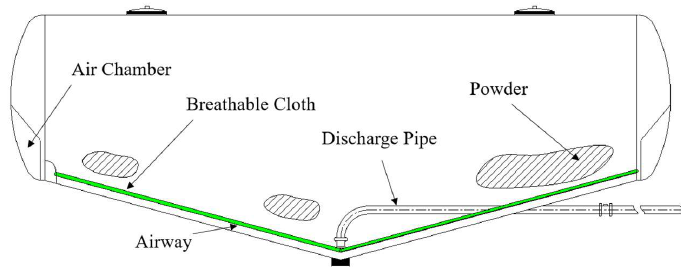
Figure 1. Physical model of fluidized bed for powder tank